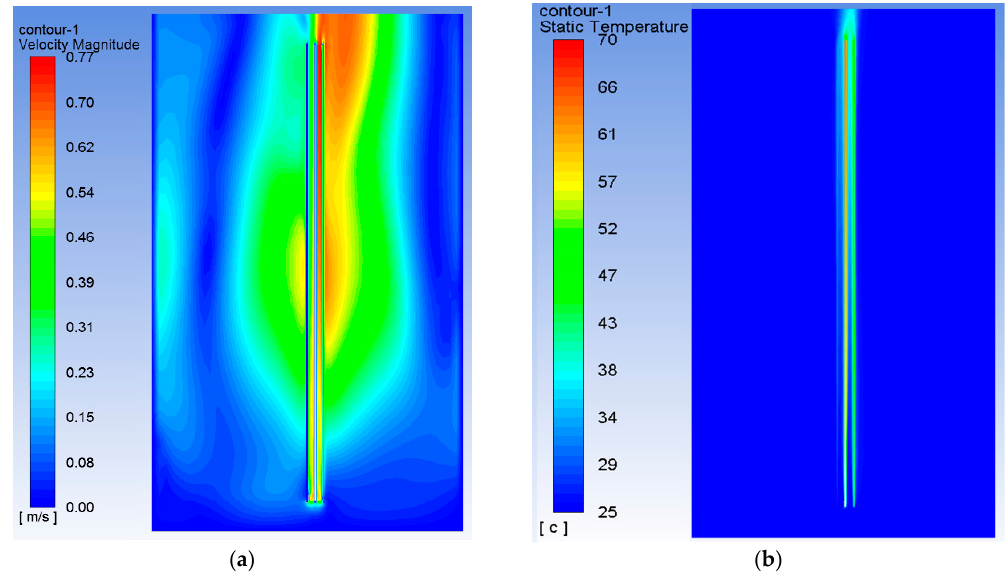
Figure 13. Air velocity distribution ( a ) and temperature distribution ( b ), for the pipe diameter of 100 mm and its length of 3 m.